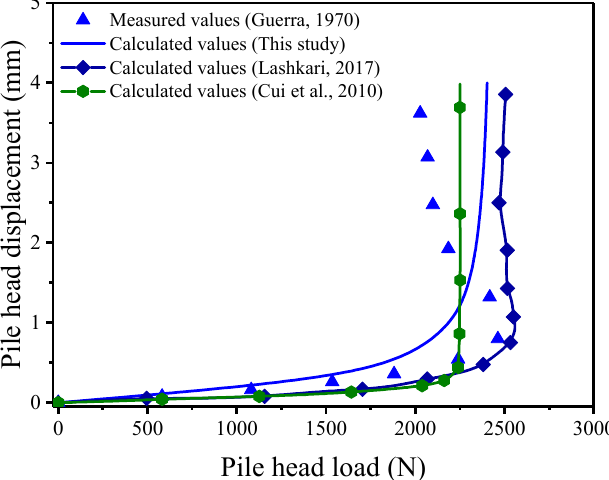
Figure 7. Comparison between calculated and centrifuge test results of a single pile ([22,35,37]).